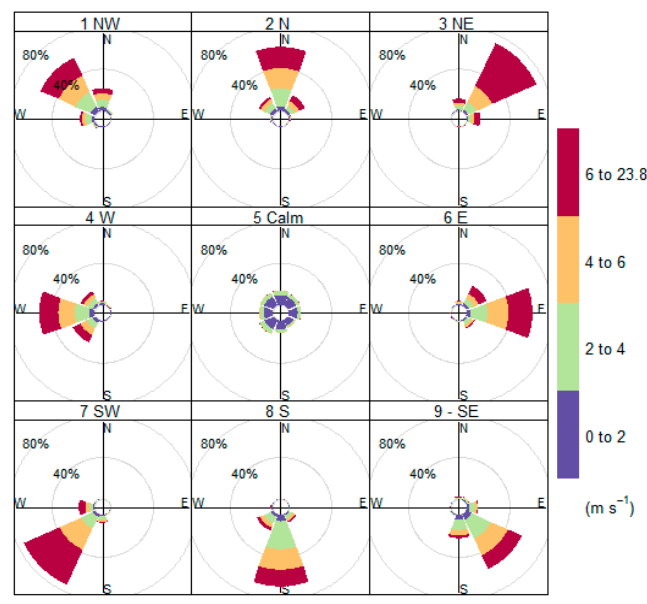
Figure 4. Matching of sampled sectors and measured wind directions.